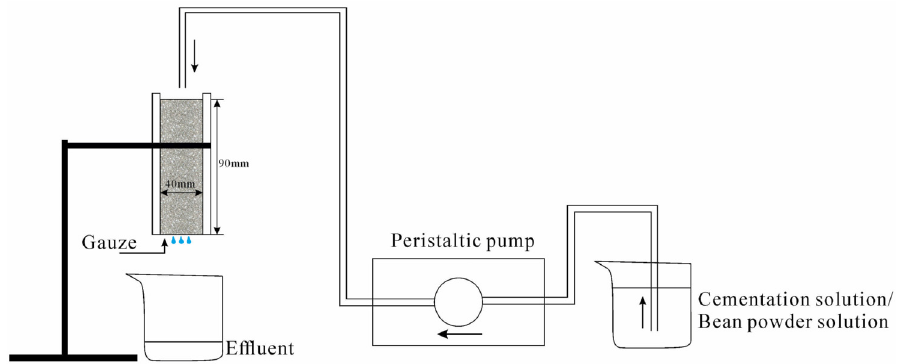
Figure 3. Schematic diagram of sand solidification test.